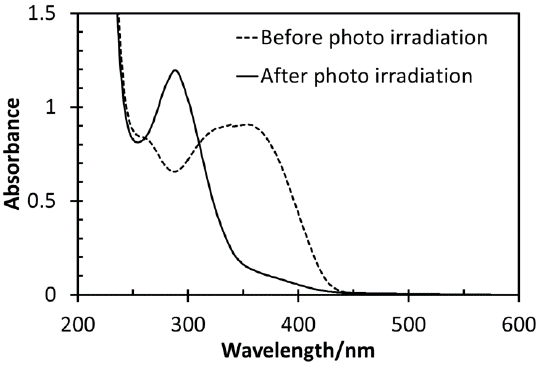
Figure 2. UV-VIS absorption spectra of PEG-P(Asp-nonyl-chal-C 8 ) (nonyl = 7.0, chal-C 8 = 8.6) micelles before photo irradiation (solid line) and after photo irradiation (dashed line) in a 0.1 mg/mL solution.